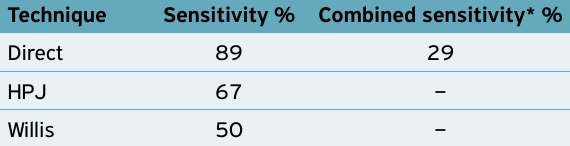
Table 1. Sensitivity analysis of HPJ, Willis and direct techniques for faecal samples from wild animals.